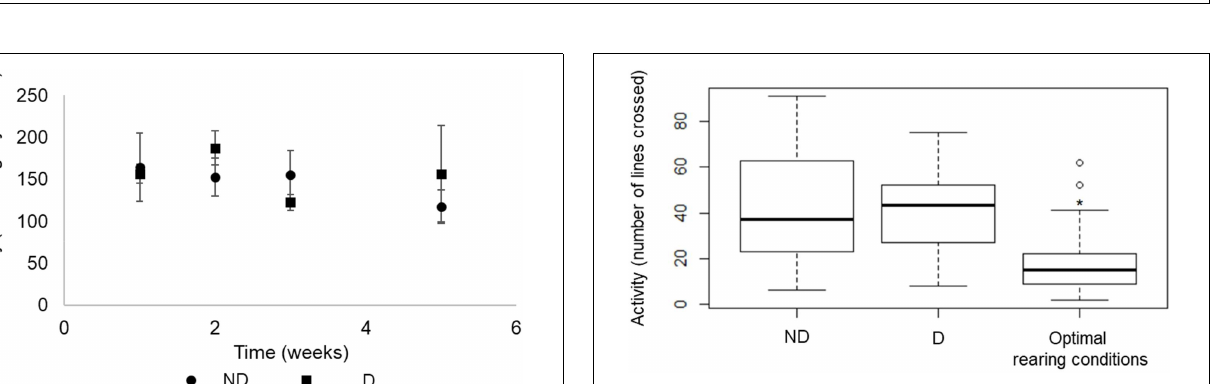
FIGURE 4 | Lactic Acid, Alanine, and Glutamic Acid (mean ± SD) in food-deprived adults of Alphitobius diaperinus exposed at 10 ± 2% RH (desiccation treatment, D) or at 60% RH (no desiccation, ND); there was no consistent difference between the two treatments over the duration of the experiment. Contents of all metabolites quantified by GC-MS are presented in Supplementary Appendix 2 .